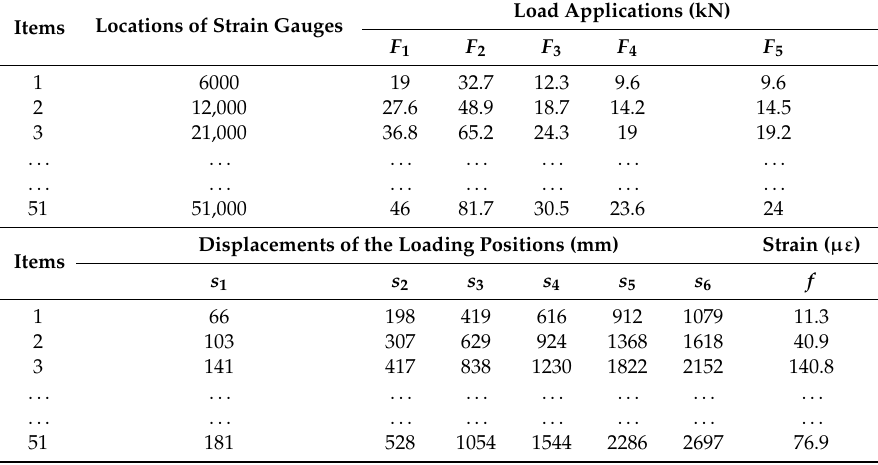
Table 7. The training samples trained by BPNN and PSO-BPNN